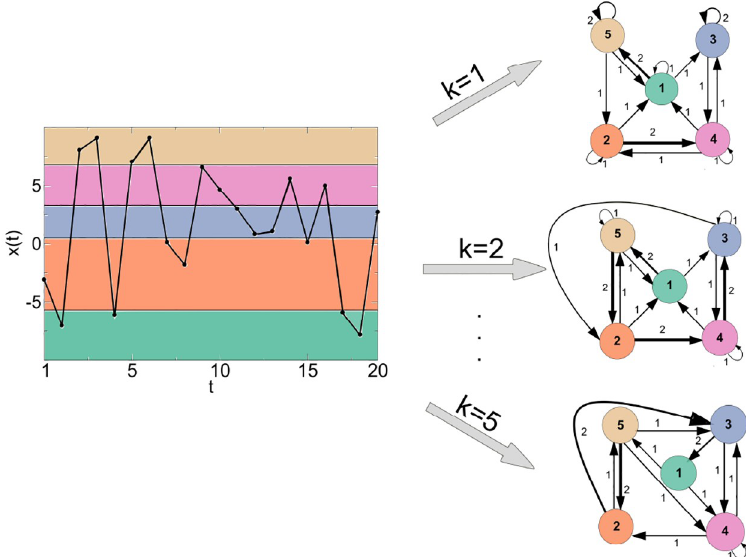
Fig 1. Example of the QG method for a time series with T = 20, Q = 5, and k = 1, 2 and 5. The quantile intervals for the sorted data are given by [ x (0), x (4)[, [ x (4), x (8)[, [ x (8), x (12)[, [ x (12), x (16)[, and [ x (16), x (20)], i.e., [ − 7.783, − 3.050 [, [ − 3.050, 0.829[, [0.829, 4.657[, [4.657, 7.070[, and [7.070, 9.090]. The quantiles are mapped into three networks with N ¼ 5 nodes each and arc weights given by (1,1,1), (1,3,1), (1,5,2), (2,1,1), (2,2,1), (2,4,2), (3,3,2), (3,4,1),